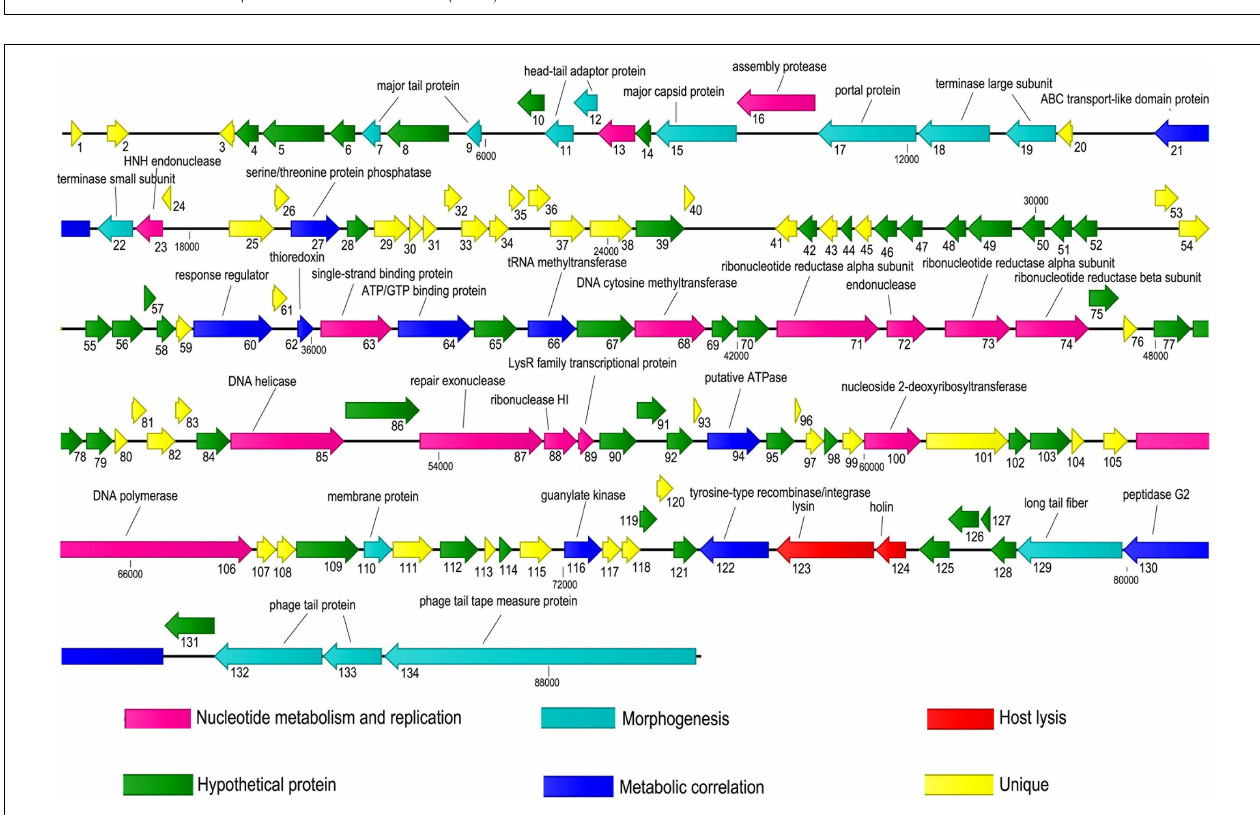
FIGURE 2 | Stability of phage JF1. (A) Stability of phage JF1 in different pHs. JF1 maintained stable activity after incubation in an SM buffer of pH 3–11 for 1 h. The values represent the means ( n = 3) and the error bars the SD. (B) Stability of phage JF1 at different temperatures. JF1 maintained stable activity after incubation at 4–50 ◦ C for 1 h. The values represent the means and SD ( n = 3).